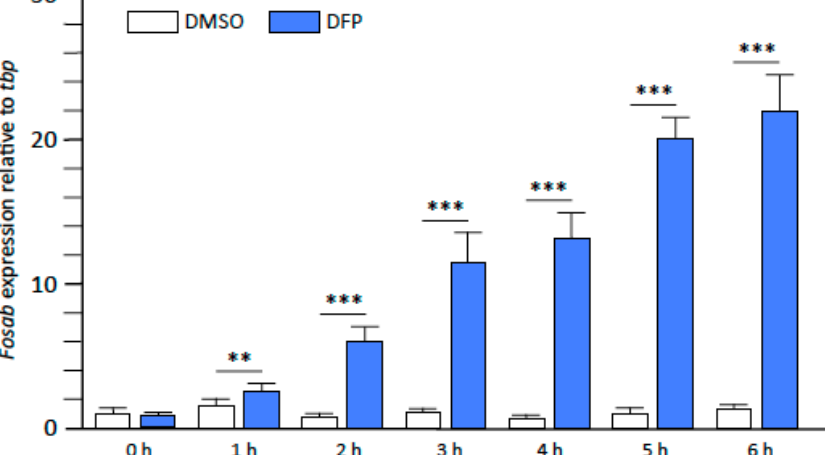
Figure 5. DFP exposure rapidly induced massive neuronal activation. Expression levels of fosab RNA relative to that of tbp RNA transcripts, from control (DMSO) and DFP-exposed (DFP) larvae, at different time points of exposure (in each condition, N = 8 samples, n = 7 larvae/sample). Error bars on all graphs represent the standard error of the mean (SEM). Statistics: **, p < 0.01; ***, p < 0.001.